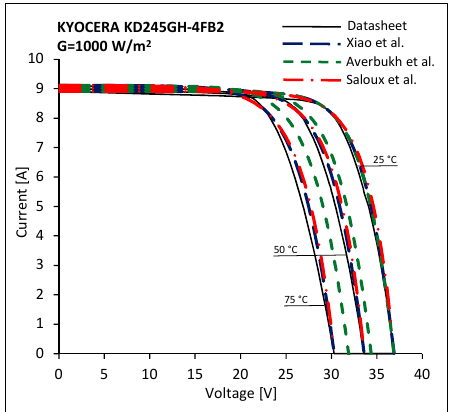
Figure 12. Comparison between the issued I-V characteristics of the Kyocera KD245GH-4FB2 at G = 1000 W/m 2 and the characteristics calculated by means of the Xiao et al. the Averbukh et al. and the Saloux et al. models.